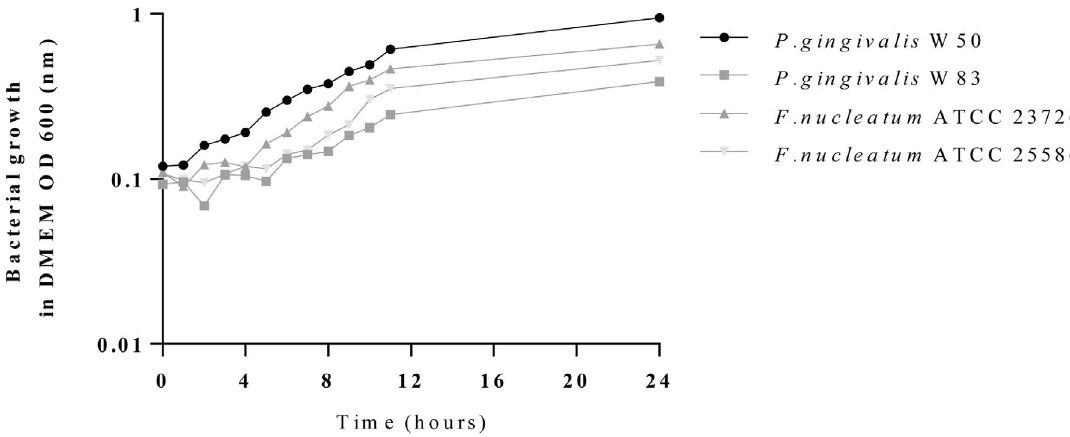
Figure 2. Bacterial growth in cell culture medium. Growth rates of bacteria in DMEM cell culture medium under anaerobic conditions (10% CO 2 , 10% H 2 , 80% N 2 ), 37 u C. Bacteria were grown in PYG medium supplemented with 5 m g/ml hemin and 1% vitamin K to the stationary phase. Subsequently, they were centrifuged, washed in PBS, and each bacterial suspension was diluted in DMEM 1:10. The OD 600 was measured at 600 nm from timepoint 0 every hour to timepoint 12 h with a final measurement after 24 h. doi:10.1371/journal.pone.0110616.g002 nucleatum ATCC 255886 infection). Overall, F. nucleatum was